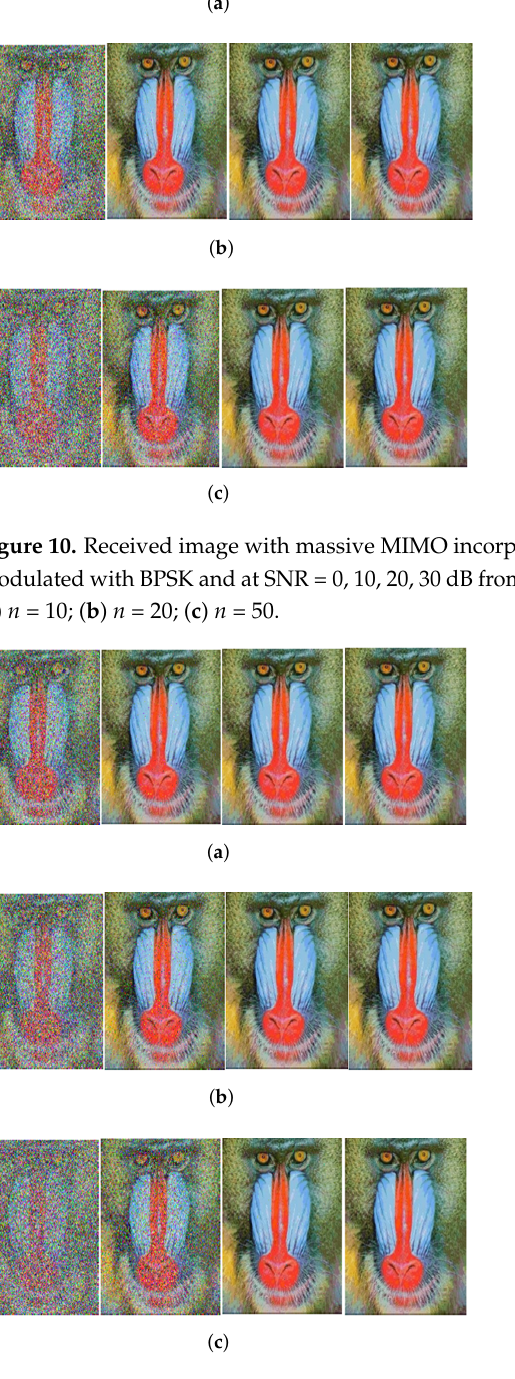
Figure 11. Received image with massive MIMO incorporated FRFT-OFDM over a Rayleigh channel, Modulated with QPSK and at SNR = 0, 10, 20, 30 dB from Left to Right for different number of users, n . ( a ) n = 10; ( b ) n = 20; ( c ) n =